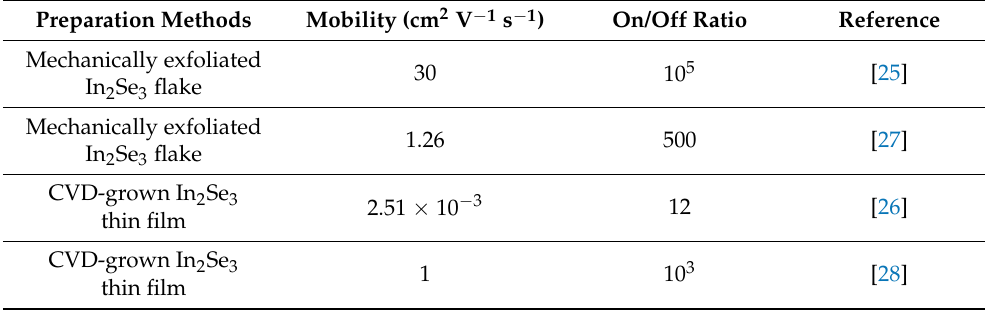
Figure 8. ( a ) I sd - V sd transfer characteristics of the LbL-assembled and spin-coated In 2 Se 3 thin film FETs on a linear scale. ( b ) I sd - V sd transfer characteristics of the LbL-assembled and spin-coated In 2 Se 3 thin film FETs on a logarithmic scale. Table 1. Comparison of In 2 Se 3 FET performance with different preparation